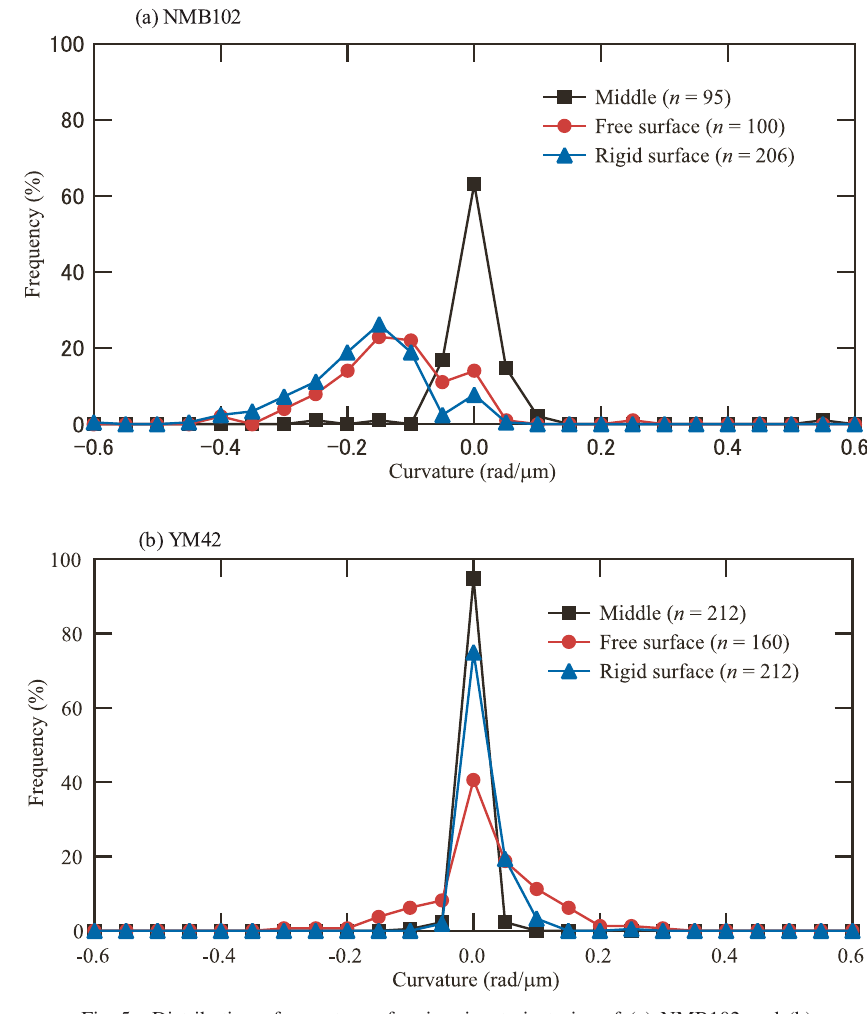
Fig. 5 Distribution of curvature of swimming trajectories of (a) NMB102 and (b) YM42. Positive value of curvature means that the cell swims in the vicinity of the boundary in the clockwise manner when viewed from the suspension to the boundary. The value n means the same as in